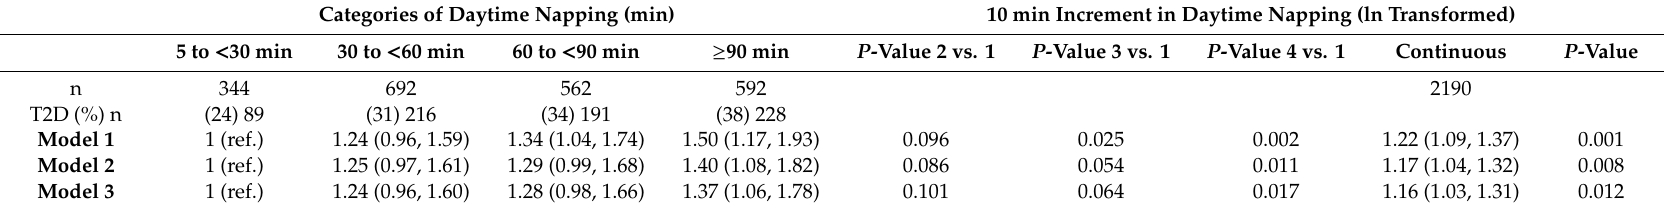
Table 2. Multivariable-Prevalence Ratio (95% CI) for type 2 diabetes according to categories of daytime napping and per increment of 10 min in daytime napping (ln-transformed).